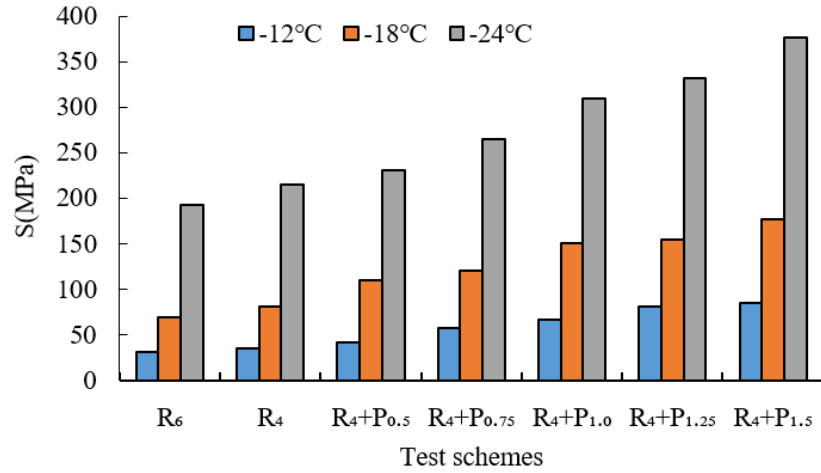
Figure 13. Creep stiffness of PPA – SBR and DH – 70# asphalt.